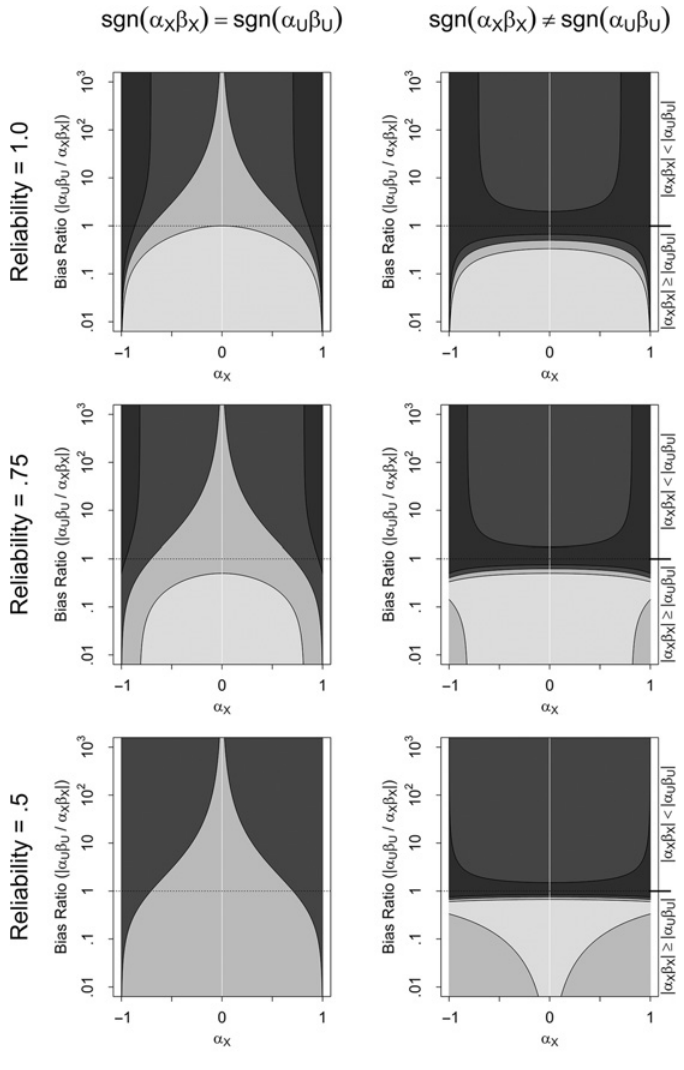
Figure 3: Increasing and decreasing OVB due to conditioning on an uncorrelated confounder X . The two dark grey areas indicate an increasing OVB, with 100%-200% (lighter shade) and 200% or more (darker shade) remaining bias. The two light grey areas indicate a decreasing OVB, with 50%-100% (darker shade) and 50% or less (lighter shade) remaining bias.